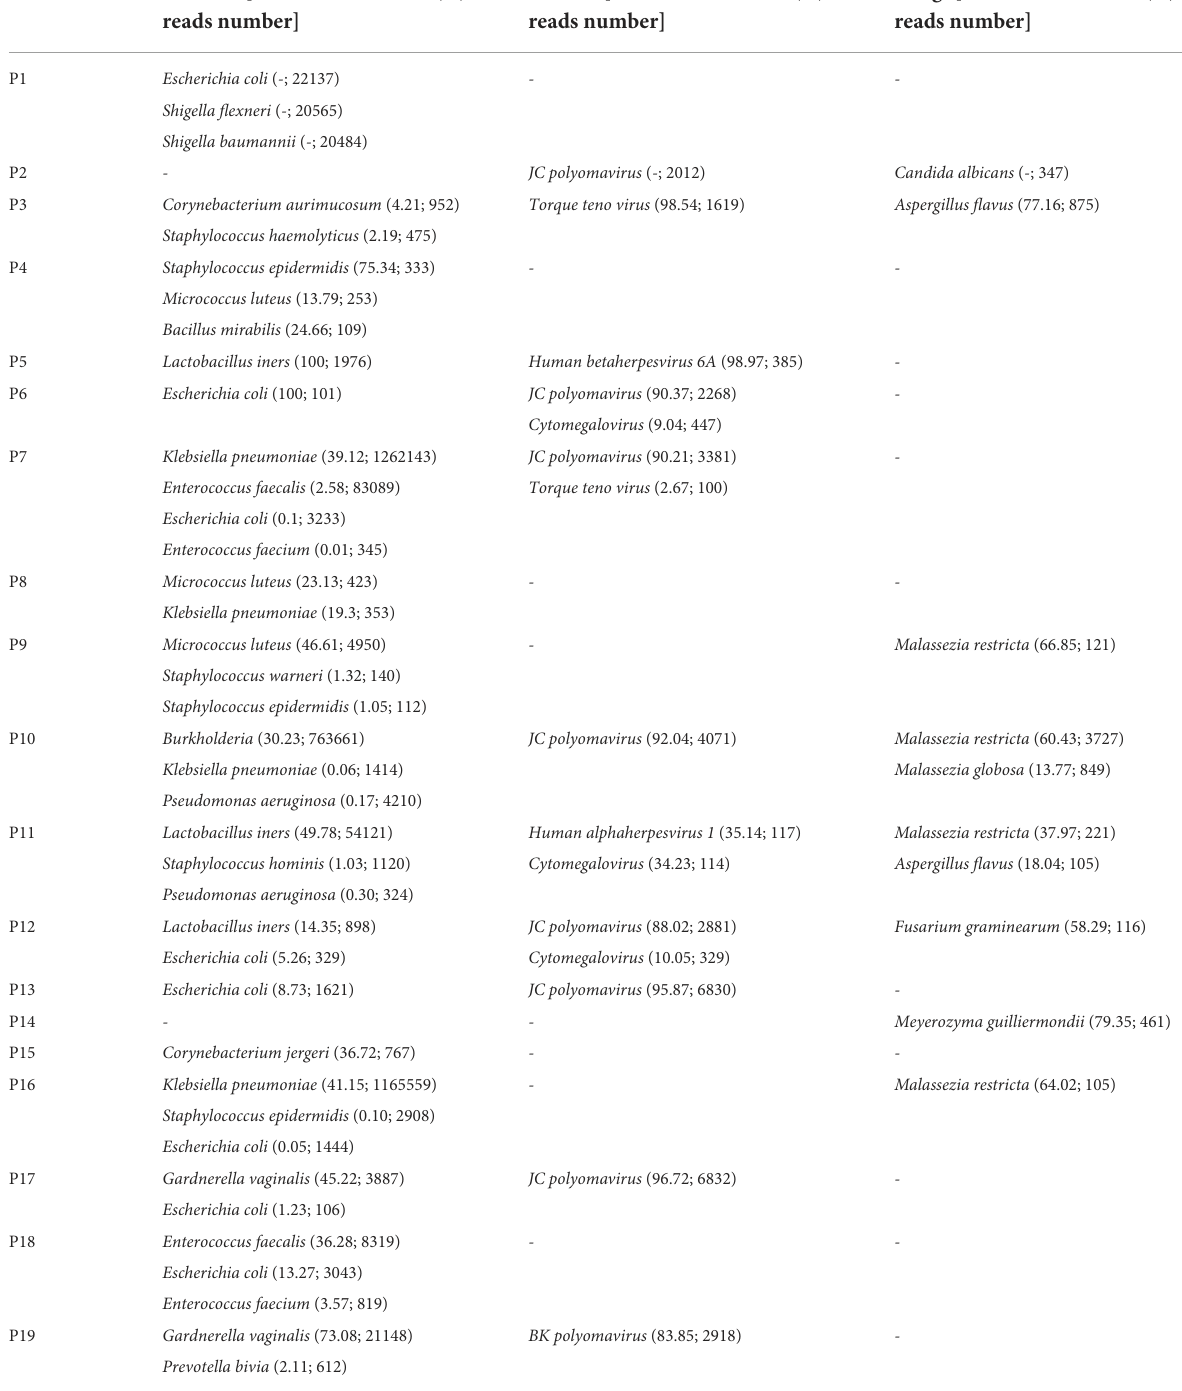
TABLE 2 The abundance and nucleic acid sequence number of various microorganisms in 19 urine